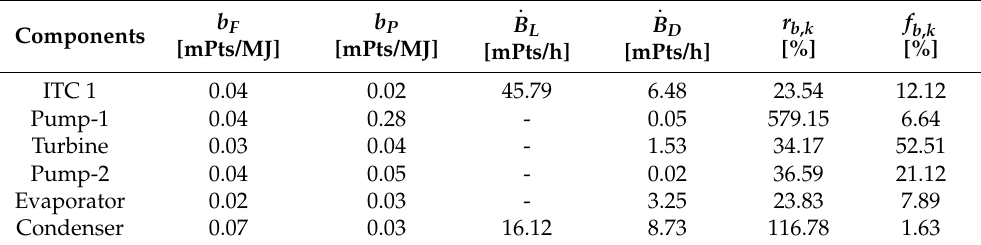
Table 14. Traditional exergo-environmental parameters for each